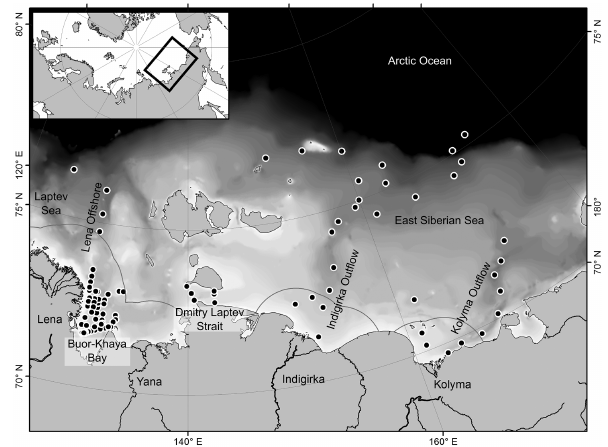
Figure 1. Map of the East Siberian Arctic Shelf (ESAS) showing the location of the ISSS-08 sampling stations. Key regions referred to in the text are highlighted. The lower courses and outflows of four great Russian Arctic rivers are